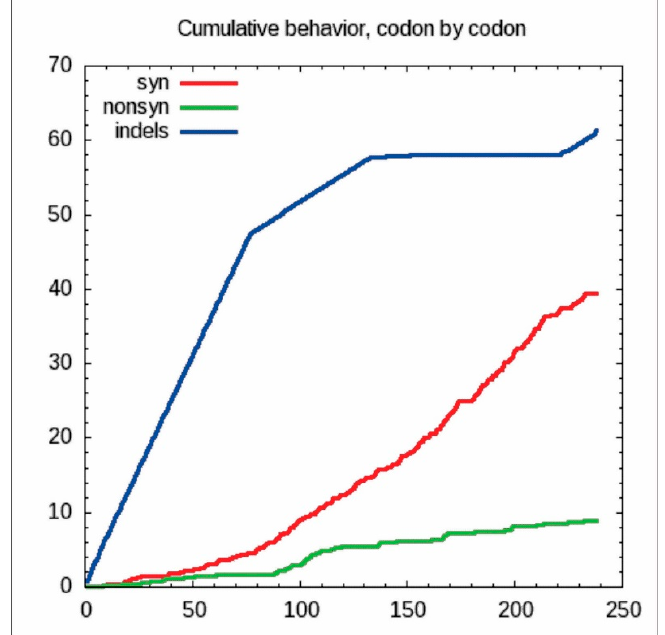
Figure 7. Cumulative behavior (codon-by-codon) of Korean isolates of Apple stem grooving virus